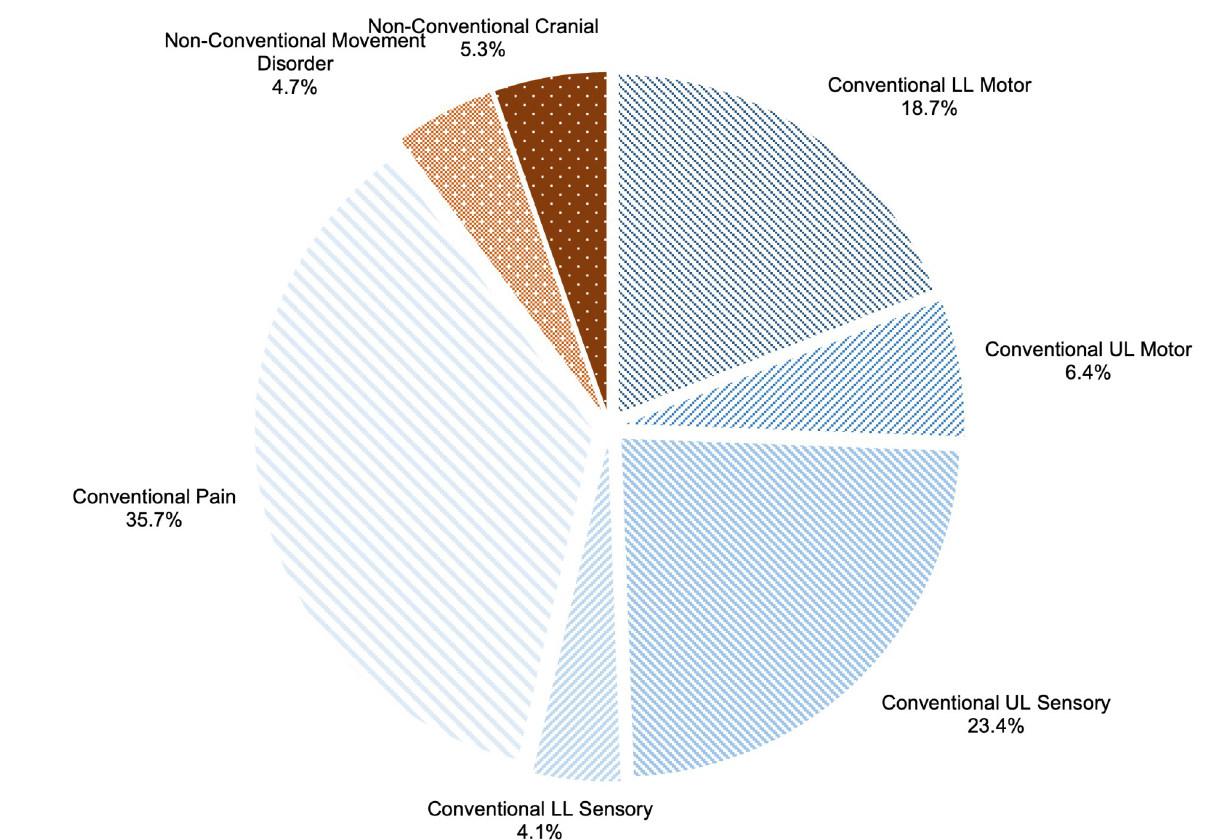
Fig 5. Pie chart illustrating the proportion of initial symptoms that were attributable to each symptom category. Conventional symptom segments are illustrated with lines and non-conventional symptom segments with dots. Categories with N � 1 have been left out for the purposes of clear